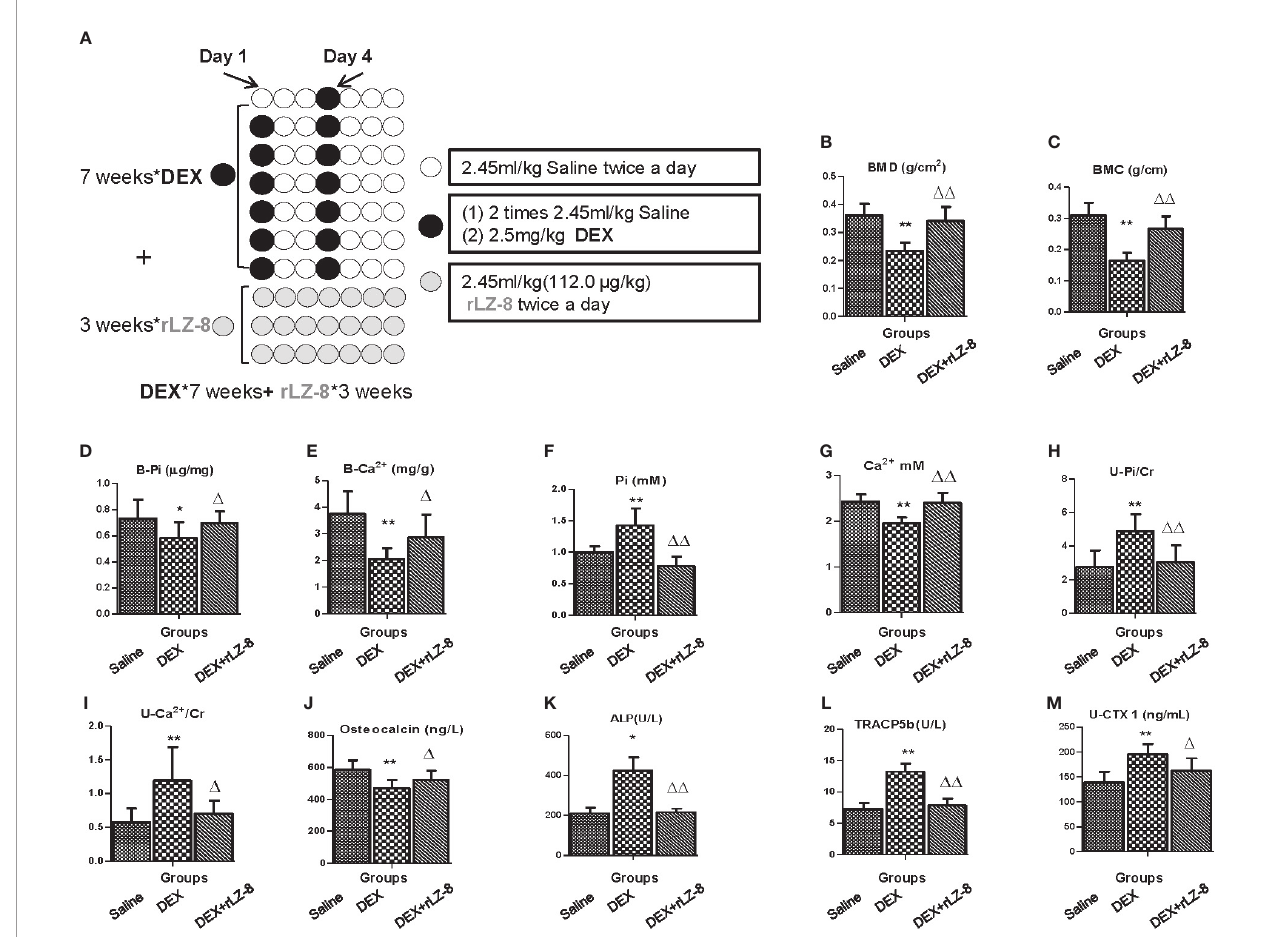
FIGURE 7 | rLZ-8 could reverse bone loss in GIOP rats. (A) Schematic diagram of experimental procedure for testing the reversal effects of rLZ-8 on bone mass of GIOP rats. (B) BMD (g/cm 2 ); (C) BMC (g/cm); (D) Phosphorus in bone ( m g/mg); (E) Calcium in bone (mg/g); (F) Serum phosphorus (mM); (G) Serum calcium (mM); (H) Urinary phosphorus/Cr (mM/mg); (I) Urinary calcium/Cr (mM/mg); (J) Serum osteocalcin (ng/L); (K) Serum ALP (U/L); (L) Serum TRACP5b (U/L); (M) Urinary CTX1/Cr (ng/ml * mg). Compared with the blank control group, * stands for P < 0.05 and ** stands for P < 0.01; Compared with the model group, △ stands for P < 0.05 and △△ stands for P <